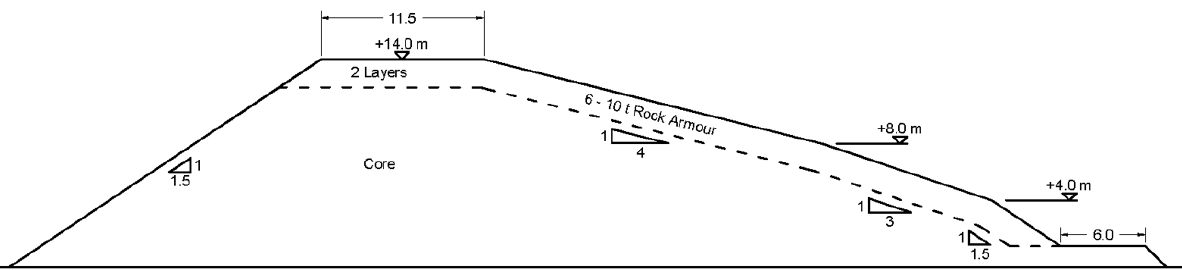
Figure 8. La Collette reclamation breakwater section, as model tested in 1993.